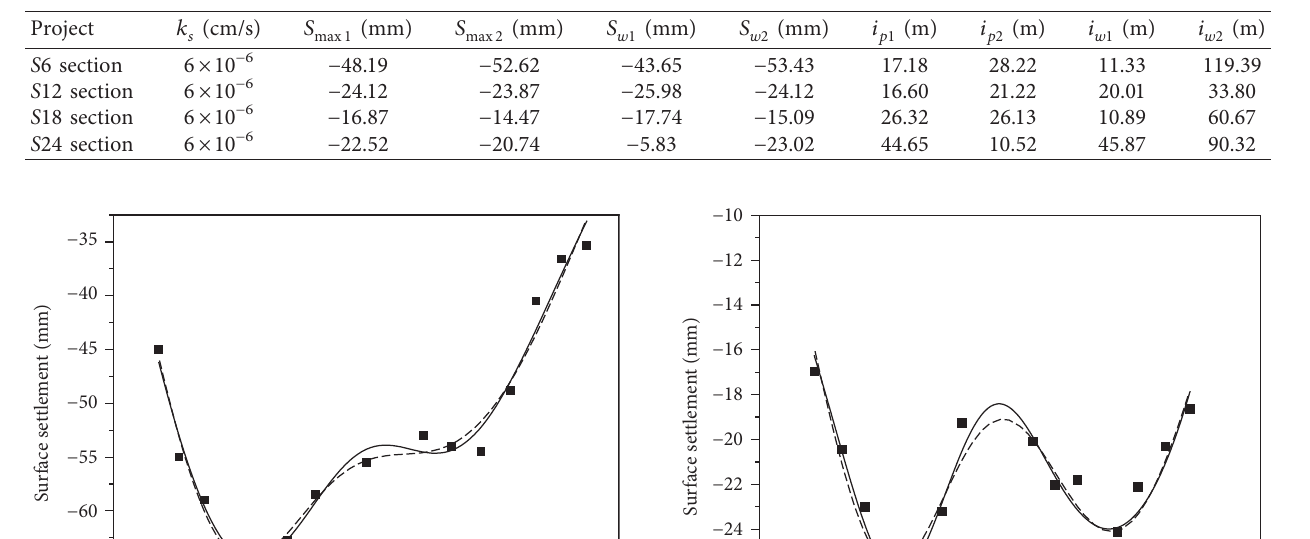
Figure 7: Comparison of surface settlement and vault settlement development. (a) Outside the river-affected area. (b) Inside the river- affected area. Table 3: Parameters of the simulation in Zizhi Tunnel.